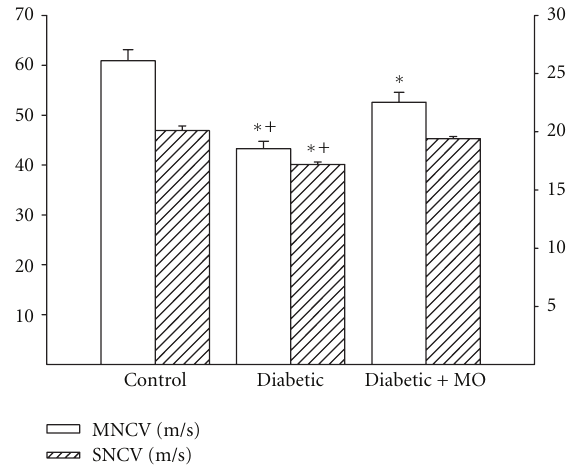
Figure 3: E ff ect of treatment of high-fat/streptozotocin diabetic rats with menhaden-oil- (MO-) supplemented diet on motor and sensory nerve conduction velocity. Motor and sensory nerve conduction velocity was examined as described in Section 2. Data are presented as the mean ± S.E.M. in m/sec. The number of rats in each group was the same as shown in Table 2. ∗ P < 0 . 05 compared to control rats; + P < 0 . 05 compared to diabetic rats.